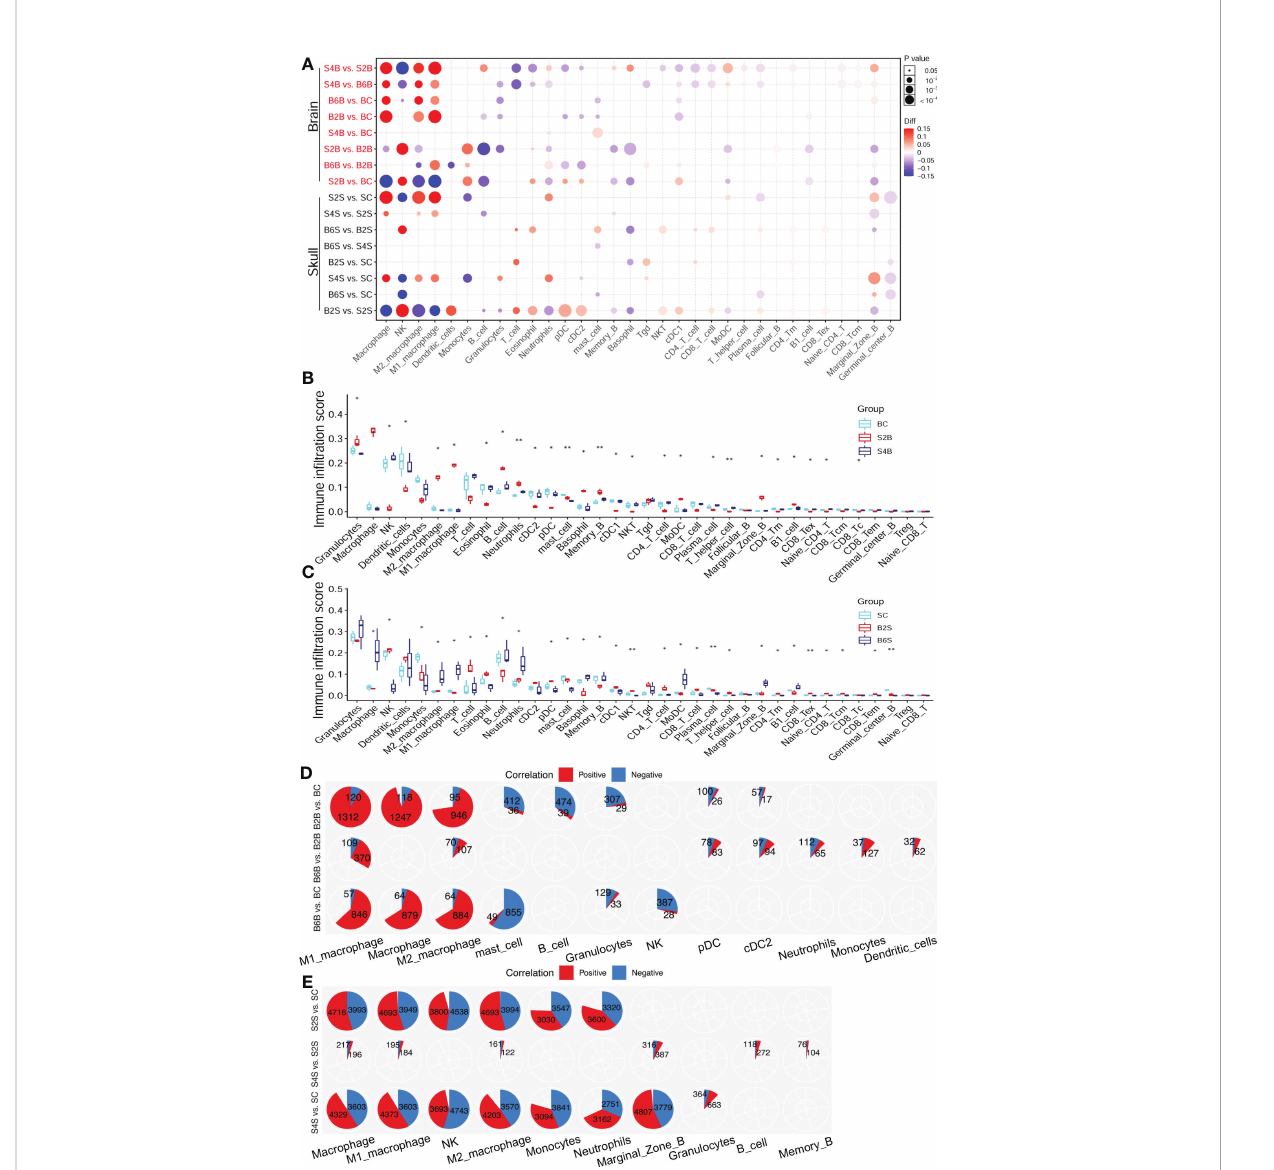
FIGURE 5 Changes in the immune cell abundance after ischemic injury. (A) Immune abundance changes in the brain and skull groups. (B, C) Boxplot of the immune cell abundance differences in the brain (B) and skull (C) groups ( n = 3; Kruskal – Wallis test: * p < 0.05, ** p < 0.01). (D, E) Positive ( red ) and negative ( blue ) correlation patterns between the ischemic injury-related genes and the different immune cell types across the brain (D) and skull (E) ischemic injury groups (Pearson ’ s correlation: r > 0.9, p < 0.05). BC , control group for the uninjured brain; B2B and B6B , brain samples of the second and sixth days after brain photothrombosis (PT); SC , control group for the uninjured skull; S2S and S4S , skull samples of the second and fourth days after skull PT; B2S and B6S , skull samples of the second and sixth days after brain PT; S2B and S4B , brain samples of the second and fourth days after skull